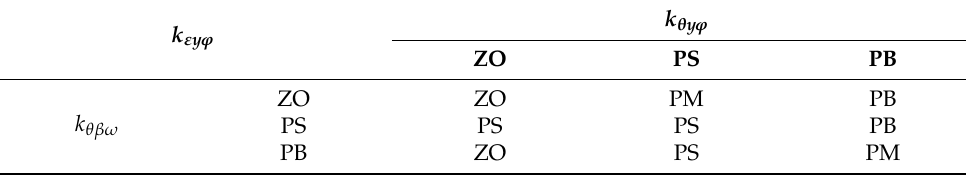
Table 1. Fuzzy rules of the lane keeping weight ratio.